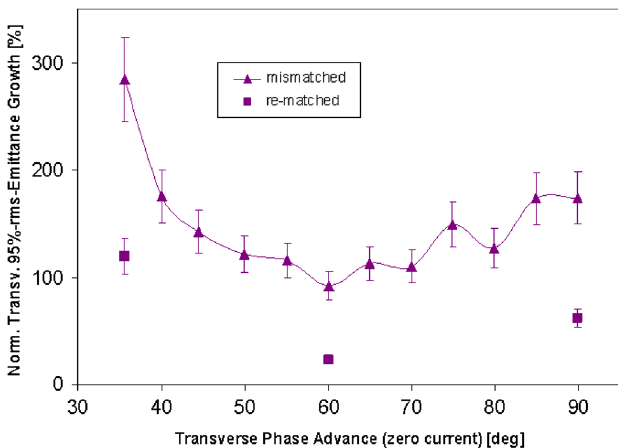
FIG. 23. (Color) Growth of the mean value of horizontal and vertical 95% rms emittance along the DTL as a function of the zero current phase advance (cid:4) o